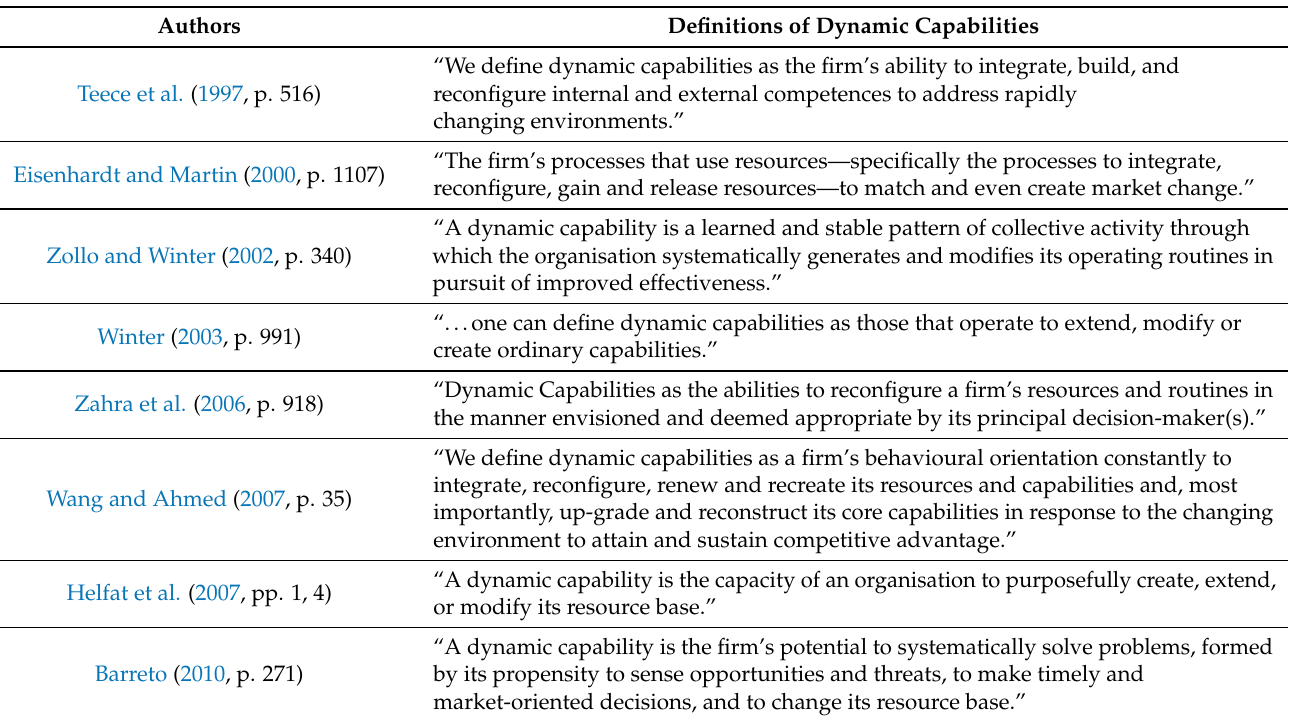
Table 1. Definitions of Dynamic